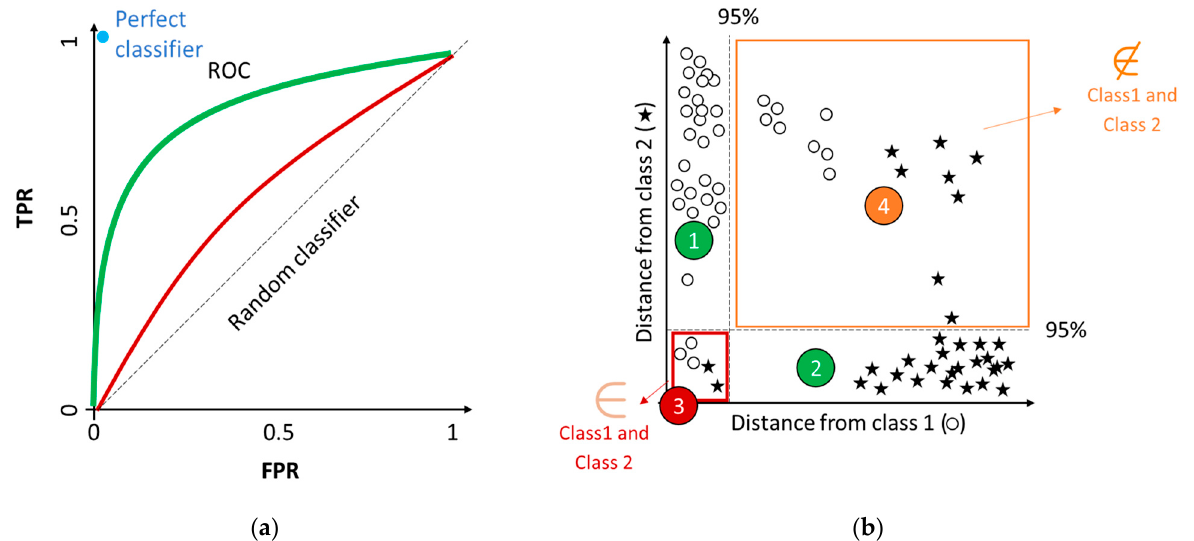
Figure 3. Graphical tools to represent classification model performance. ( a ) Receiver operating characteristic (ROC) curves; ( b ) Coomans’ plot.